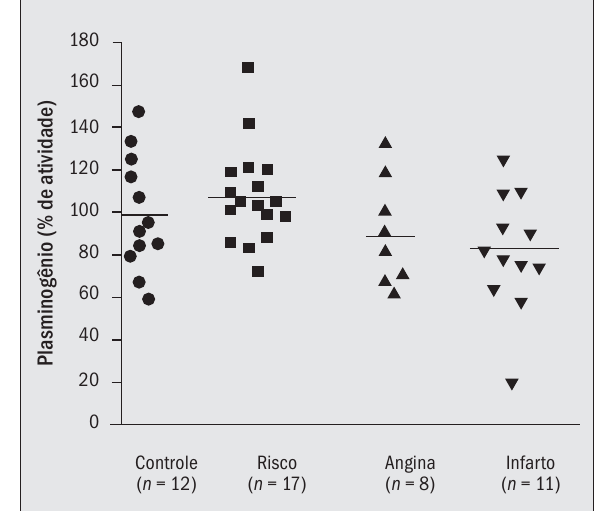
Figura 5 – Resultados da determinação da atividade do plasminogênio nos grupos estudados. As barras horizontais indicam as médias obtidas para cada grupo ( n = número de amostras). Nenhuma diferença foi observada entre as médias dos quatro